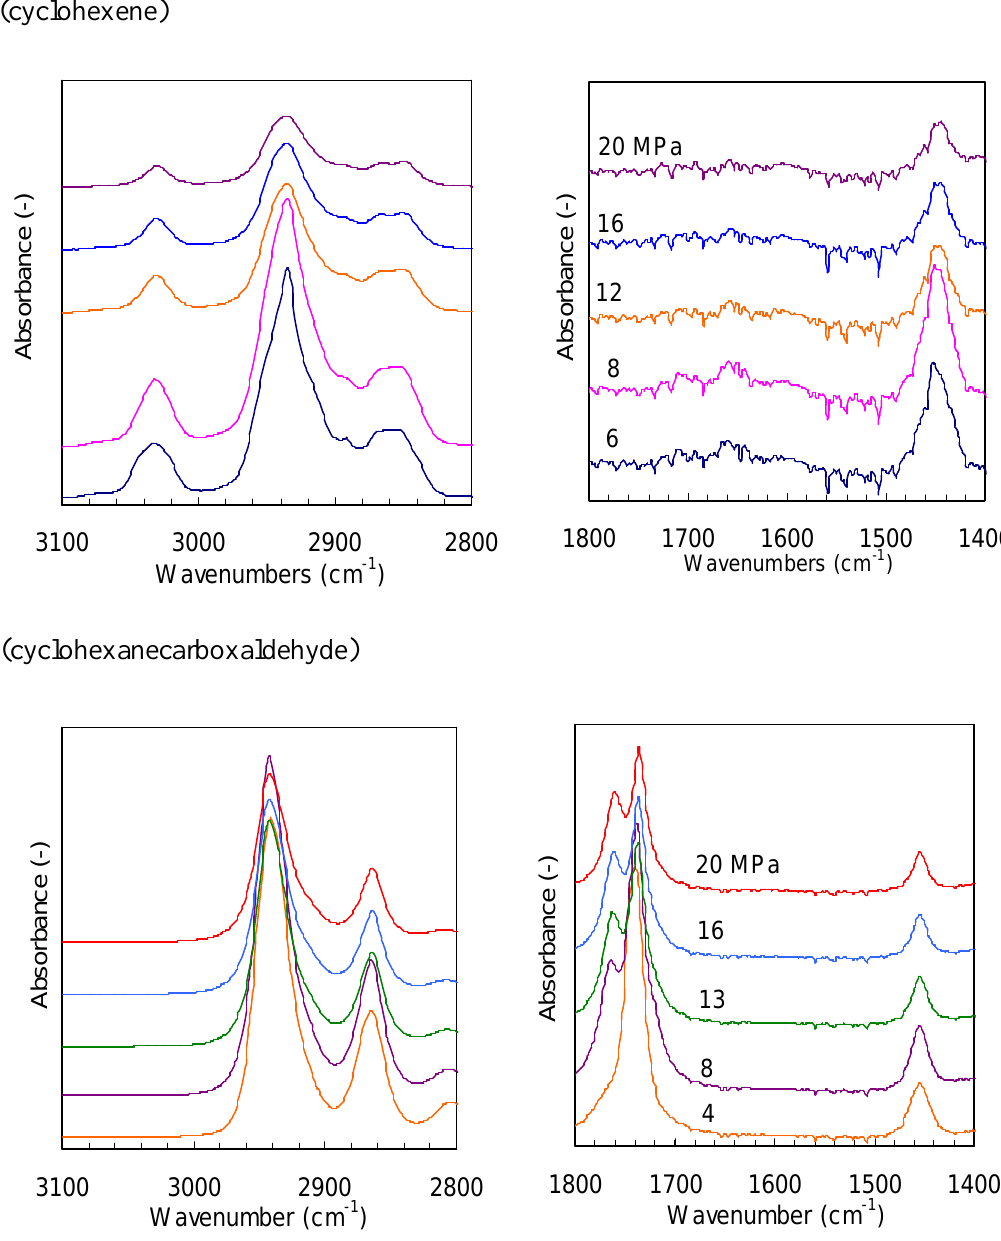
Figure 5. High pressure FTIR spectra of 1 and 2 in 4 MPa H